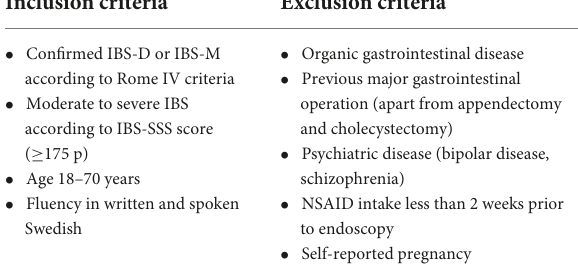
TABLE 1 Inclusion and exclusion criteria for the